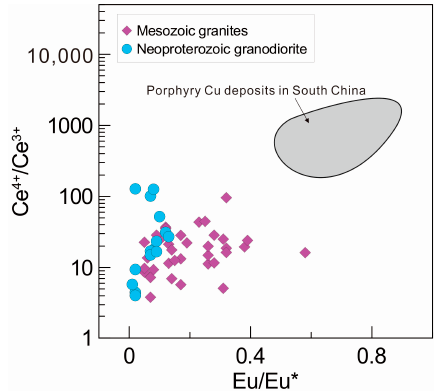
Figure 15. Zircon Ce 4+ /Ce 3+ vs. Eu/Eu* for the Shimensi granodiorite. Data of the ore-related Mesozoic Shimensi granites are from Wei et al. [6]. Data source of major porphyry Cu deposits in South China: Dexing [53], Shaxi [54], Dabaoshan [55].